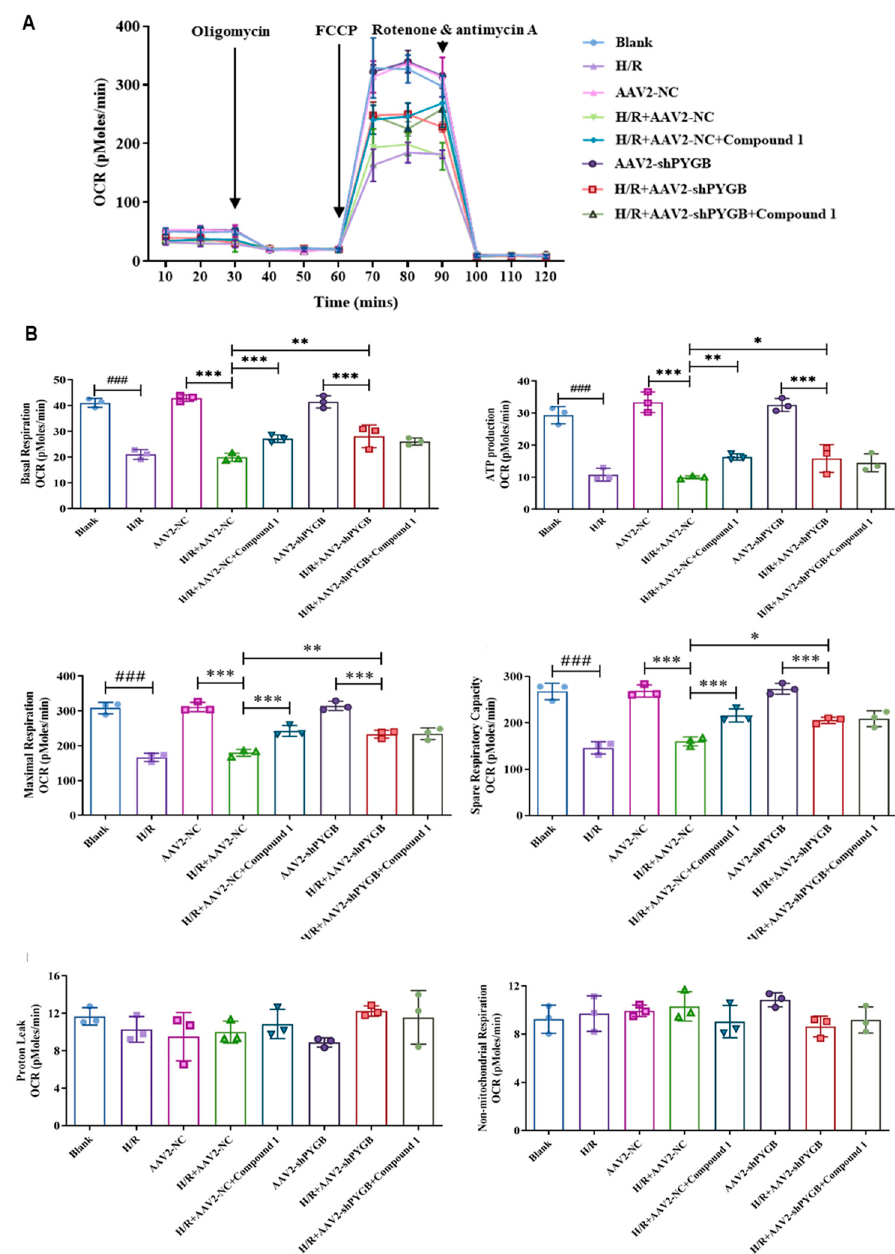
Figure 6. ( A ) Mouse astrocytes after H/R treatment with various drug administration methods; the real-time OCR was measured using Seahorse XF96 Extracellular Flux analyzer. The basal OCR was measured at three time points, after which four chemicals were sequentially injected into the medium: the ATP synthase inhibitor oligomycin, the uncoupler FCCP, rotenone, and antimycin A. ( B ) Bar graphs of basal respiration, ATP production, maximal respiration, spare respiratory capacity, proton leak, and non-mitochondrial respiration. Data represent mean ± SD (* p < 0.05, ** p < 0.01 *** p < 0.001; ### p < 0.001).